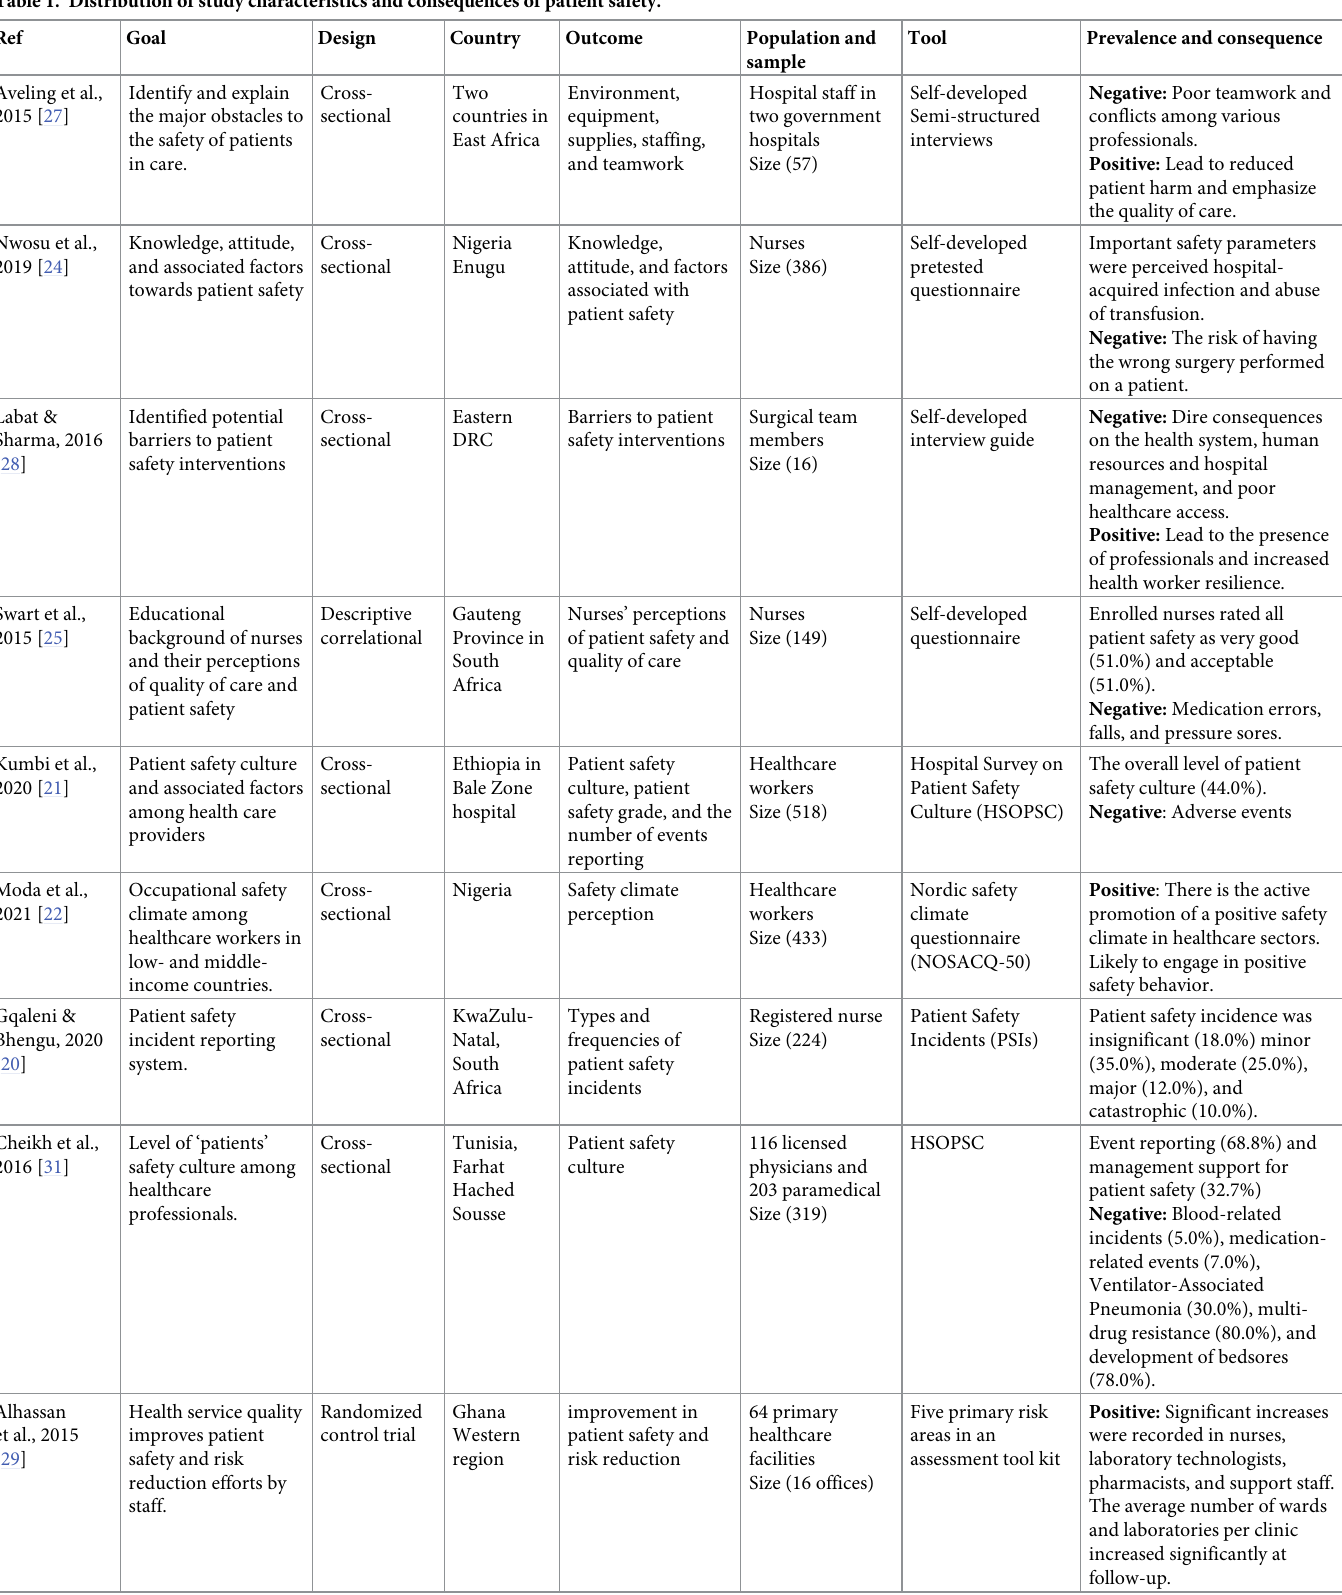
Table 1. Distribution of study characteristics and consequences of patient